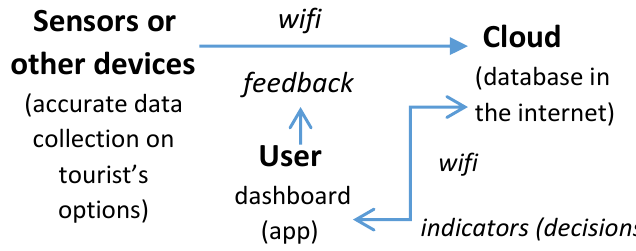
Figure 6. A cyber-physical system